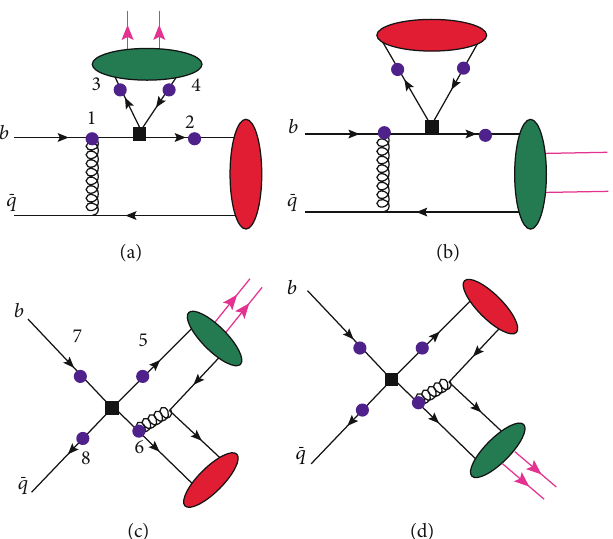
Figure 2: Typical Feynman diagrams for the quasi-two-body decay B ⟶ K ð R ⟶ Þ K + K − in PQCD, where the black squares stand for the weak vertices, large (purple) spots on the quark lines denote possible attachments of hard gluons, the green ellipse represents kaon-pair, and the red one is the light bachelor K meson Table 1: CP averaged branching fractions (in 10 − 6 ) of B ⟶ K ð R ⟶ Þ K + K − decays in PQCD [20] together with experimental data [39]. Decay modes